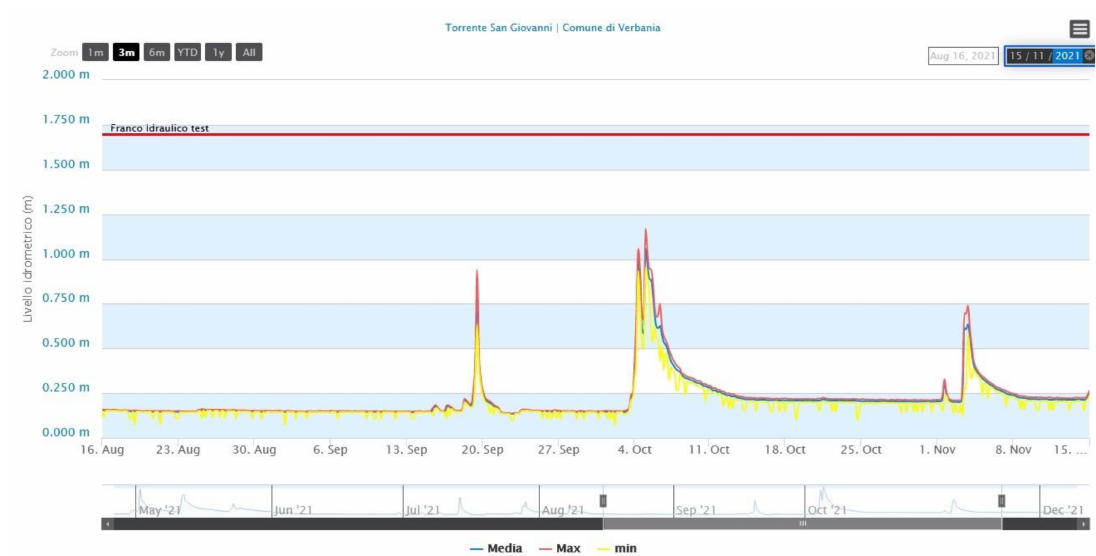
Figure 5. Web representation of the near real time trend of river level during the last 3 months. Blue line represents mean values, red lines maximum levels, and yellow line minimum